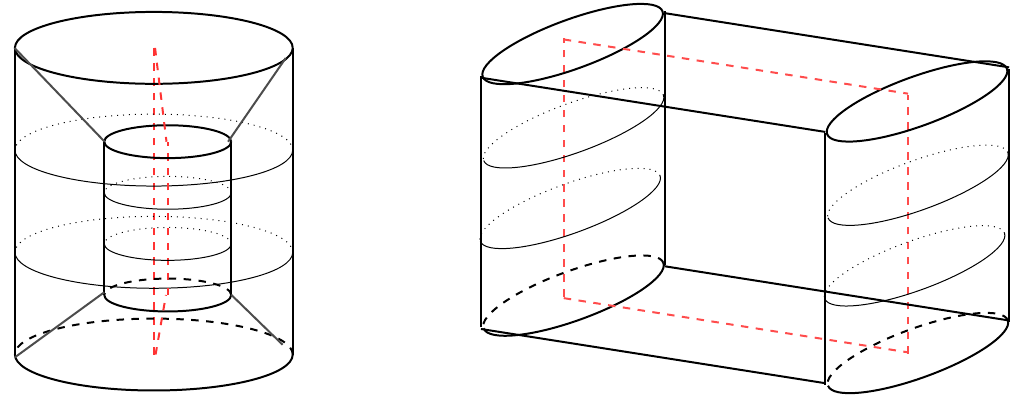
Figure 2 . Di(cid:11)erent 2D projections of a 4D hyper-cylinder. The red dashed lines indicate the 2D axis where r =